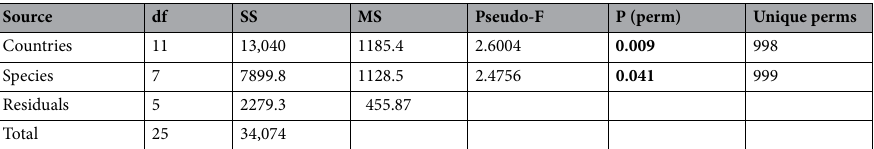
Table 4. Permanova analysis for Countries and tsetse species for Sodalis and trypanosome (single and multiple) infection prevalence. Within the table, statistically significant differences ( P < 0.05) can be seen in bold values in countries and tsetse species. Perm(s) = permutations.